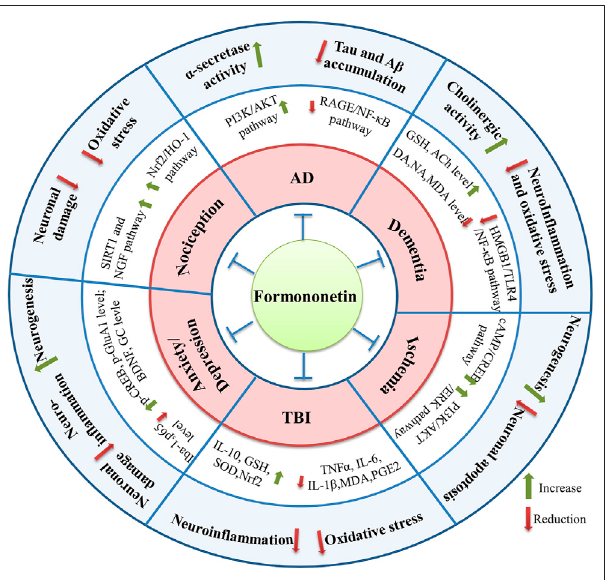
FIGURE2| Themoleculartargetsinvolvedintheneuroprotectiveeffects of